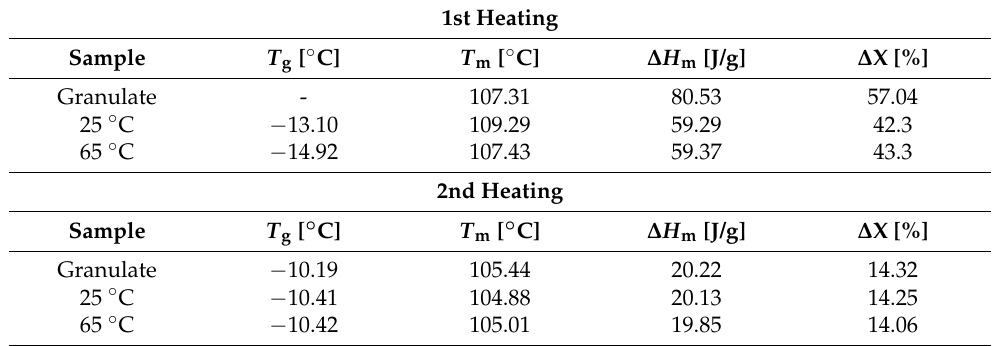
Table 2. The thermal characteristic (according to DSC) of the PDO prior to (granulate) and following